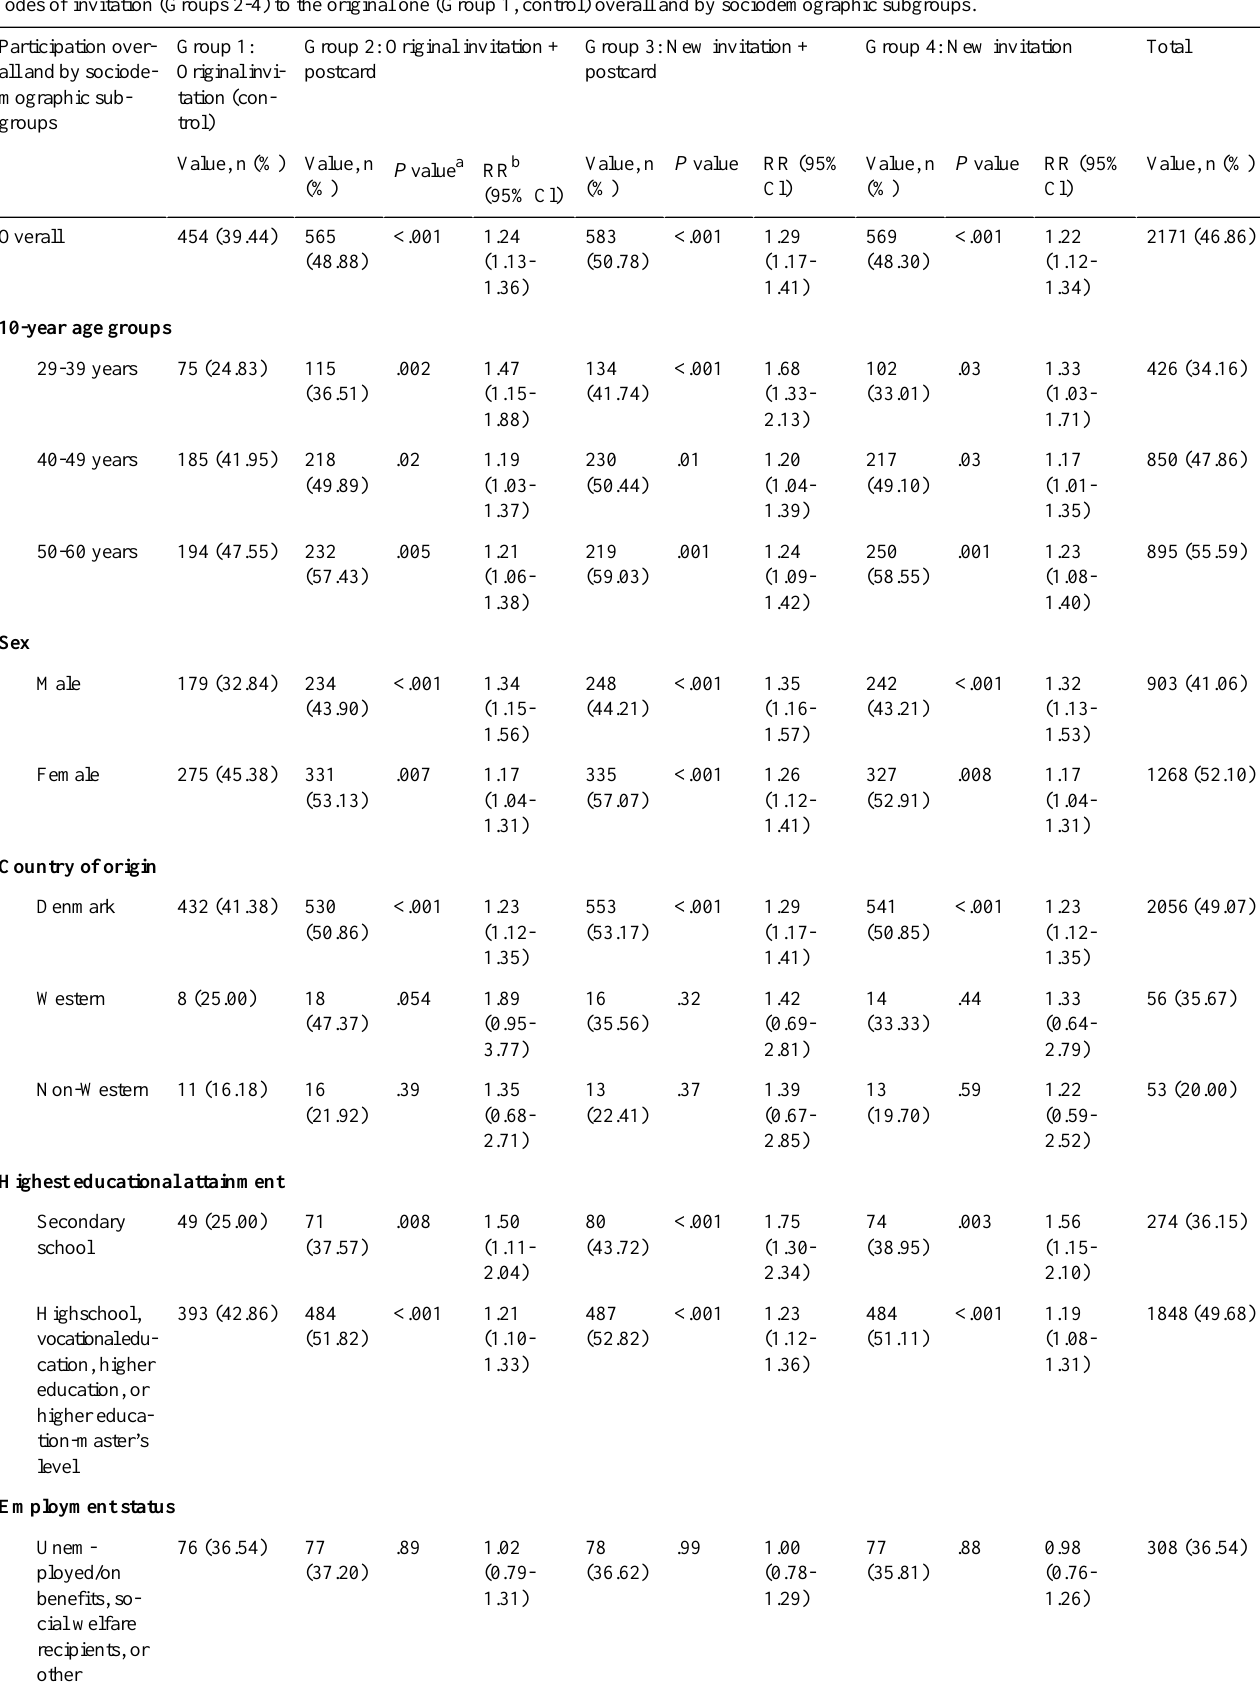
Table 3. Participation in a preventive primary care program (TOF pilot2) and risk ratios of participation obtained from comparing each of the new modes of invitation (Groups 2-4) to the original one (Group 1, control) overall and by sociodemographic